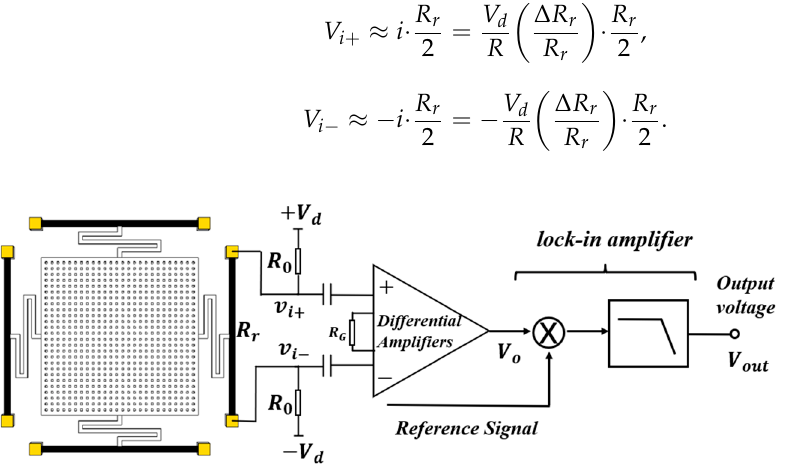
Figure 9. The measurement principle of the sensor.